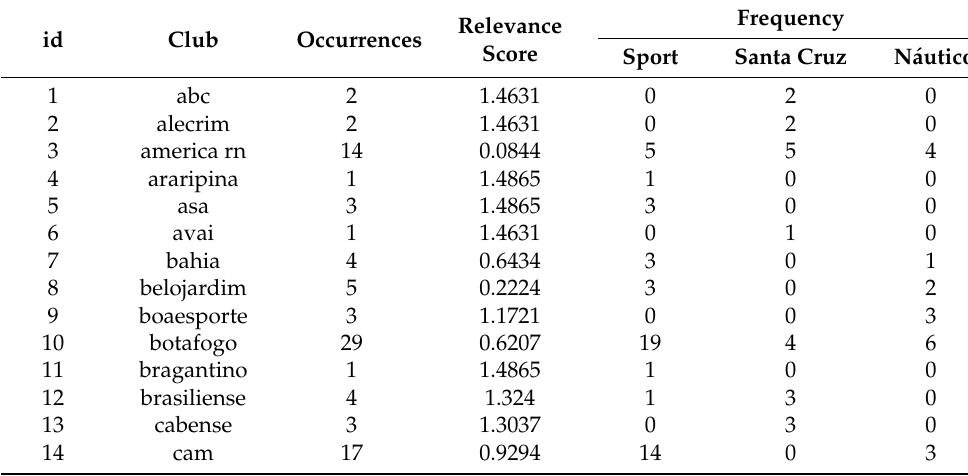
Table A2. Relevance and frequency from the hooligan